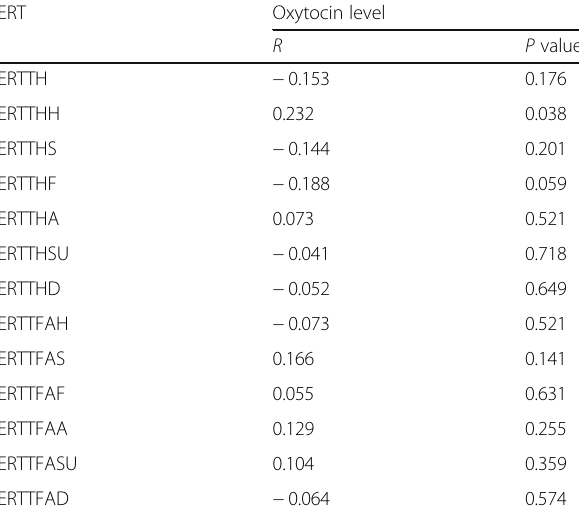
Table 5 Correlation between salivary oxytocin level and items of ERT (total hits, total hits and false alarm for each emotion